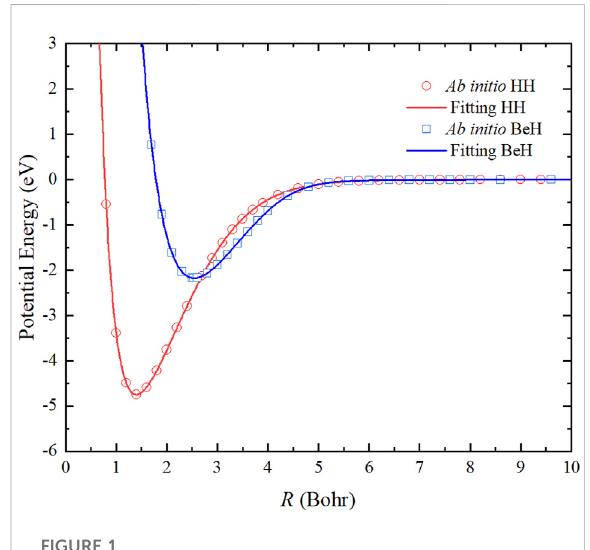
FIGURE. 2 Distribution of the PIP-NN fi tting errors of the ground-state BeH 2